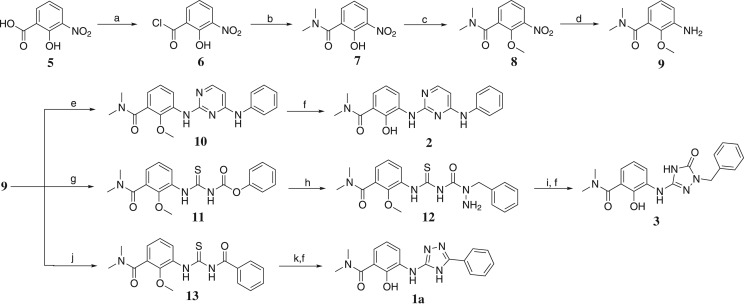
Modification of the right-hand part. Reagents and conditions: a, thionyl chloride, reflux; b, dimethylamine hydrochloride, DIPEA, CH2Cl2; c, dimethyl sulfate, K2CO3, acetone; d, Fe, NH4Cl, EtOH/H2O; e, 2-chloro-N-phenylpyrimidin-4-amine, Pd(OAc)2, Cs2CO3, Xanphos, 1,4-dioxane; f, 1 M BBr3, CH2Cl2; g, KSCN, phenyl chloroformate, acetone; h, benzylhydrazine dihydrochloride, MeOH; i, EtOH, reflux; j, KSCN, benzoyl chloride, acetone; and k, hydrazine hydrate, EtOH.